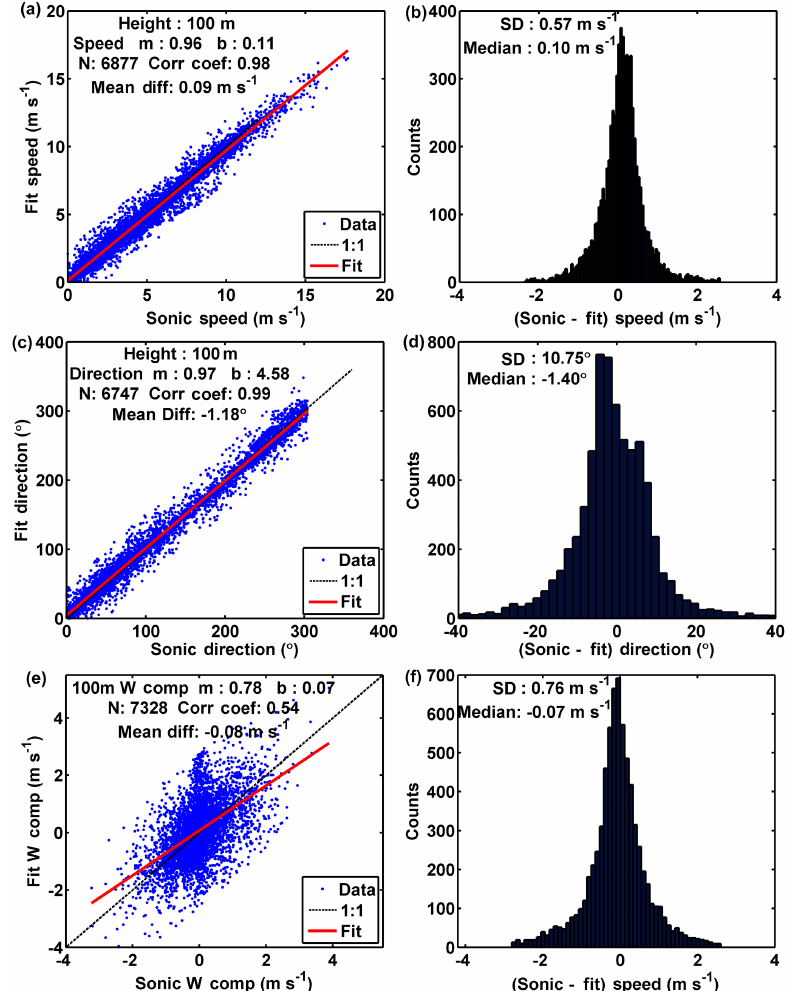
Figure 9. Comparison of the (a, b) wind speed, (c, d) wind direction and (e, f) vertical velocity measurements from the SCB technique with the measurements made by the sonic